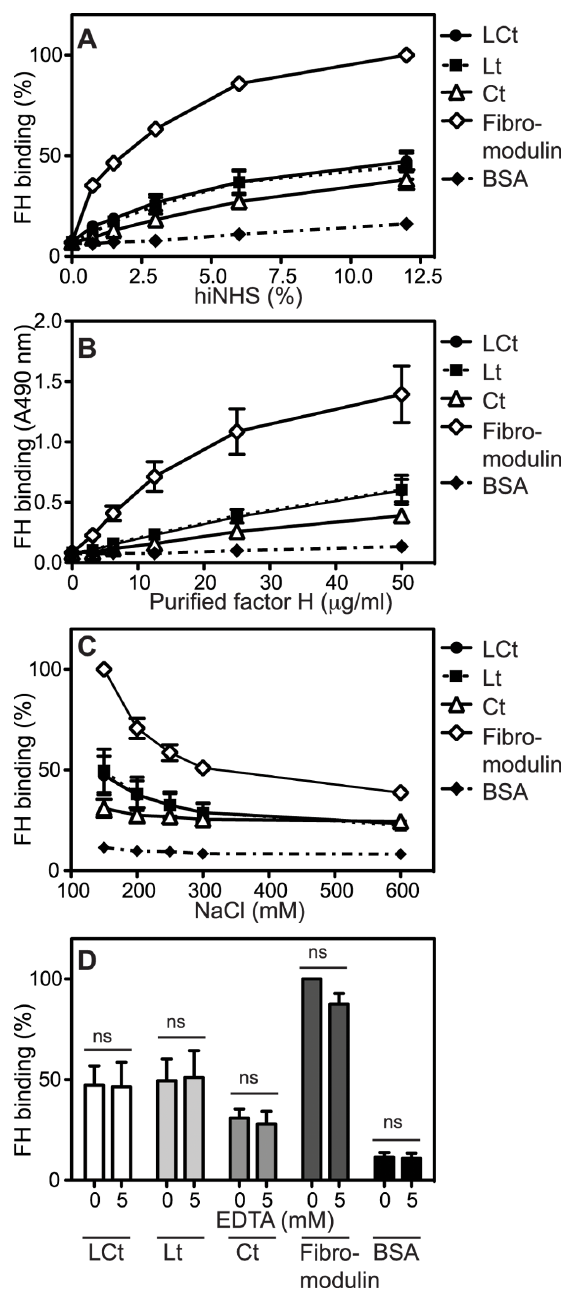
Figure 7. Lectin domain of aggrecan G3 module binds factor H (FH). Microtiter plates were coated with fibromodulin (positive control for binding of FH), LCt, Lt, Ct and BSA (negative control) and the binding of FH from heat-inactivated NHS (hi-NHS) ( A ) or solution containing purified FH ( B ) was detected using specific antibodies. Fibromodulin, LCt, Lt, Ct and BSA were coated onto microtiter plates and incubated with purified FH in a buffer supplemented with increasing NaCl concentrations ( C ) or EDTA ( D ). In A, C and D absorbance was normalized relative to the highest absorbance value obtained with fibromodulin in each figure. The graphs show the mean and SD of three independent experiments. The differences in binding using different EDTA concentrations (D) were not statistically signifi- cant, calculated using two-way ANOVA with Bonferroni posttest. (*, p , 0.05, **, p , 0.01, ***, p ,